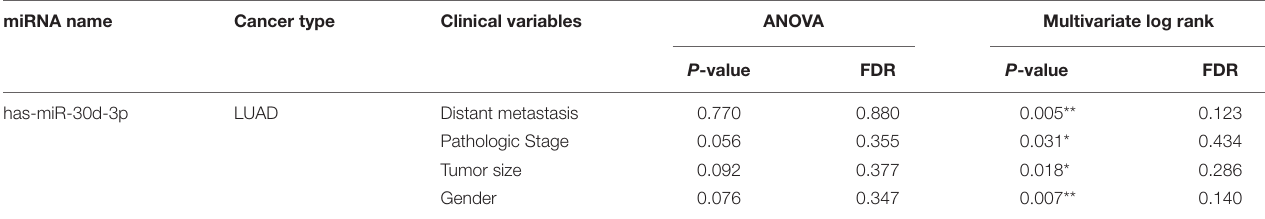
TABLE 6 | The association of hsa-miR-30d-3p with clinical variables in LUAD. miRNA name Cancer type Clinical variables ANOVA